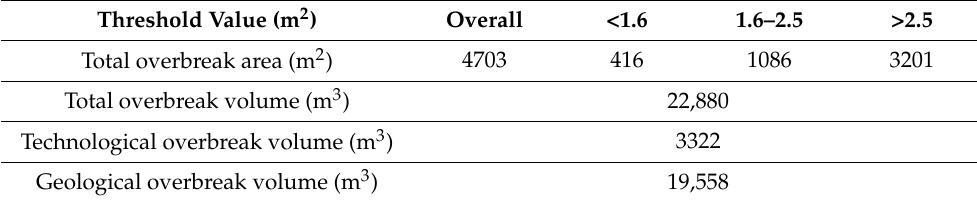
Table 4. Calculated technological and geological overbreak area and